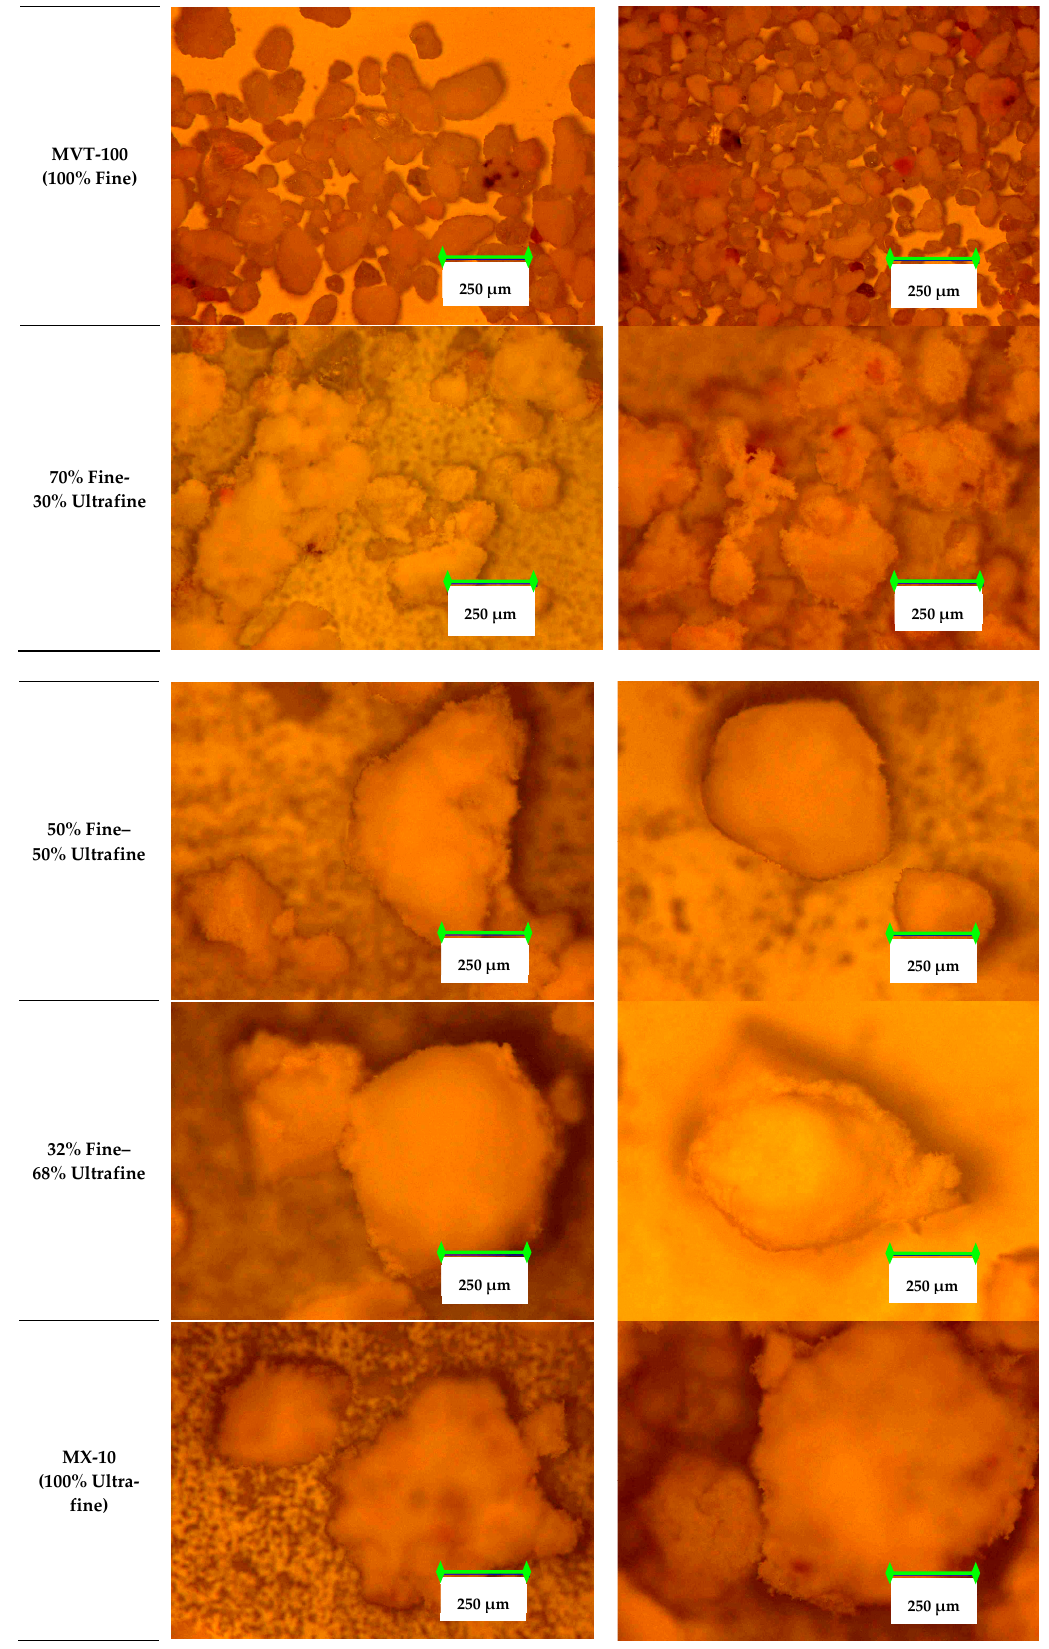
Figure 20. Pictures taken from the microscope for formed natural agglomerates on the microscope slides. Each row shows two exemplary pictures for each material or material mixtures. These pictures taken from the microscope show that for fine particles, almost all of the particles are single particles with different shapes and sizes according to the size distribution of this material. The natural agglomerates of the mixture of 70% of fine and 30% of ultra-fine particles show some small agglomerates, mostly with fine particles in the core. This means that the ultra-fine powders stick to the surface of fine particles and form agglomerates. By increasing further the percentage of ultra-fine powders to 50, 68 and 100 percent, thus increasing the value of cohesiveness, the size of natural agglomerates increases. The pictures also show that the sphericity of the agglomerates is increased when increasing the ultra-fine particles in the mixture. After starting fluidization, in a competition between the transport of agglomerates by the gas flow and the cohesive forces between them, they become restructured regarding the number of constituent particles. They can be disintegrated into smaller agglomerates or even single particles. This new configuration of agglomerates is called fluidized agglomerates. Due to considerable cohesive forces between the agglomerate and peripheral adhered particles, some larger agglomerates may be created. When increasing the size of agglomerates due to high cohesive force between particles, more kinetic energy (superficial gas velocity) and larger forces (bed pressure drop) are needed to reach the disruption point and start fluidization (even partial). Therefore, due to the high intensity of cohesiveness, the maximum bed pressure drop (peak point) during fluidization process